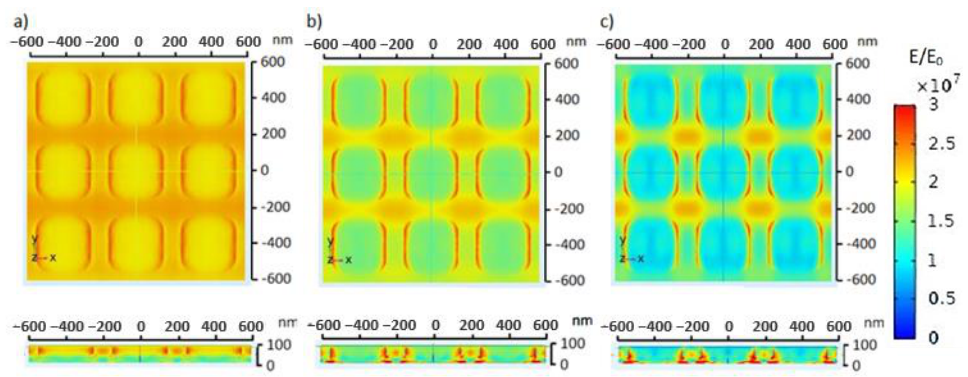
Figure 8. Top view and side view of the electric field distribution on the ZnO nanosquare irradiated with electromagnetic waves with a wavelength of 550 nm in ( a ) hypoglycemia, ( b ) normal, and ( c ) hyperglycemia blood media.